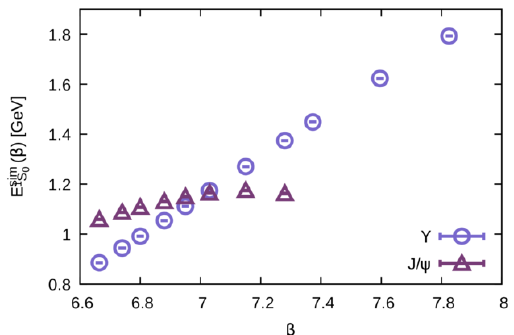
Figure 7 . The lattice spacing dependent energy E sim (circles) and charmonium (triangles), as obtained from raw lattice NRQCD correlators. Together with the PDG masses it enters the shift function C ( (cid:12) ) = M exp